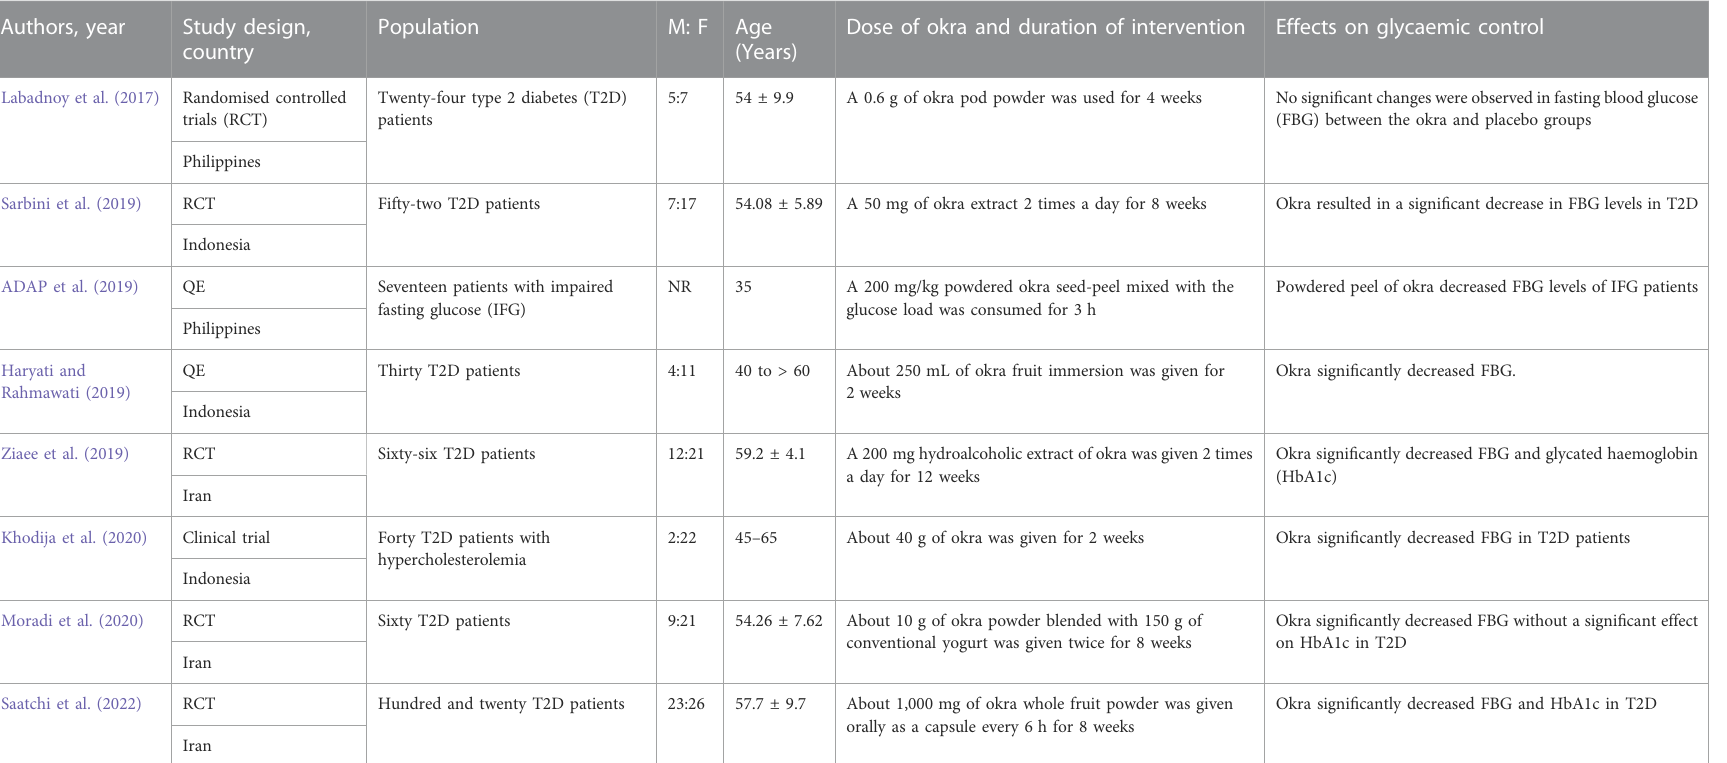
TABLE 1 Overview characteristics of included clinical studies exploring the effects of okra in pre-diabetes and type 2